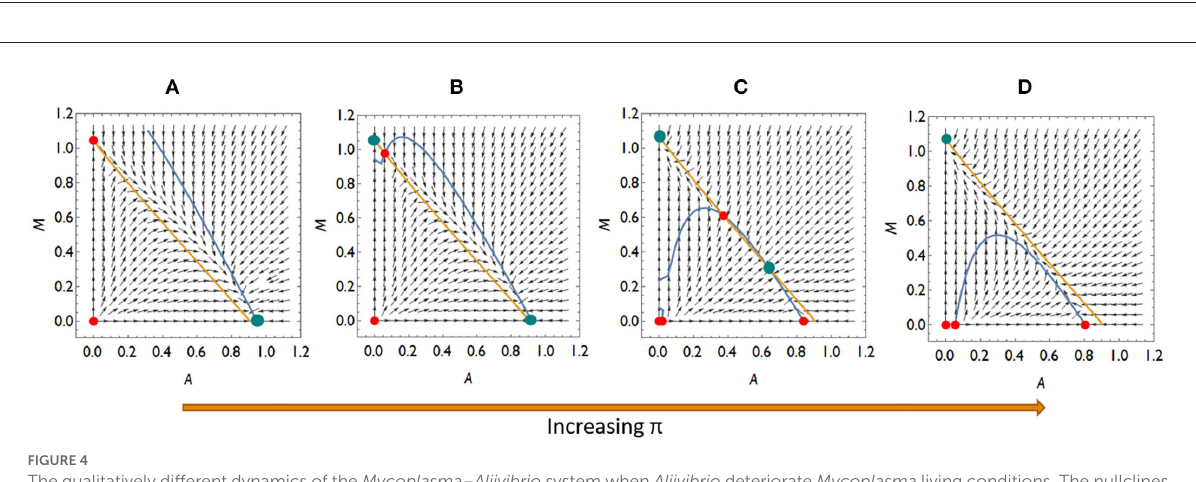
(Figure 4A). After the treatment, parameter I 0 recovers leading to an increase of π again, but if this recovered π is not high enough, then Aliivibrio remains dominant (Figure 4B) or the two strains coexist after reinvasion of Mycoplasma (Figure 4C). The observation of different microbial states of the hosts after treatment (Figure 1) can be the consequence of different health states, such as the immune efficiency π